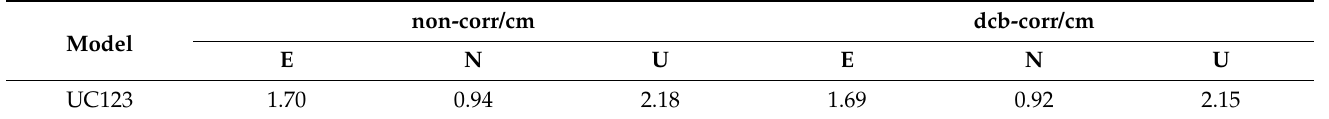
Table 8. Average positioning accuracy of PPP after convergence for UC123 model.